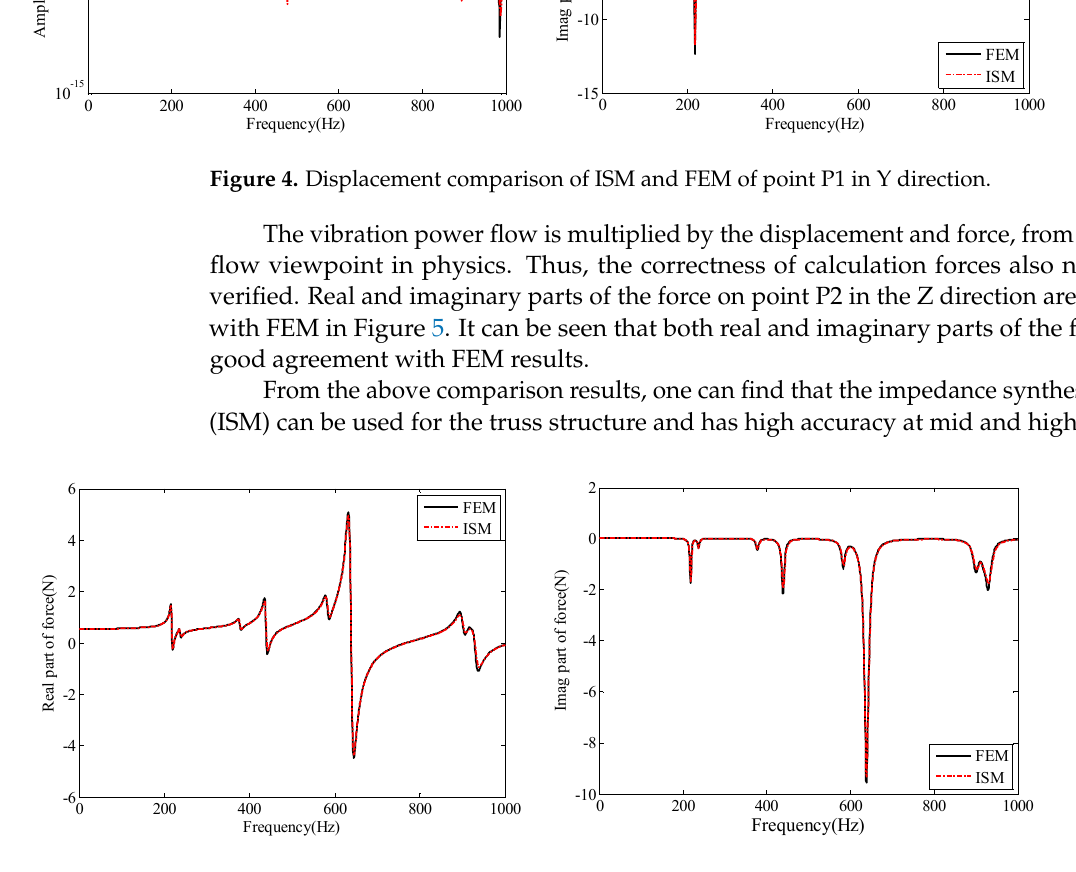
Figure 5. Force comparison of ISM and FEM of point P2 on the Z direction. From the above comparison results, one can find that the impedance synthesis method (ISM) can be used for the truss structure and has high accuracy at mid and high frequency. 3.2. Periodic Frame Structure The periodically two-dimensional truss structure is shown in Figure 6. The whole calculation structure should be divided into 15 sub-structures, A1–A15, and the boundary is points P9 and P10 are clamped. The cross-section of each truss is a pipe, and the inner radius is 80 mm and 79 mm, respectively. A harmonic excitation is applied on point P1 in the z-direction. The Young’s modulus, density, and Poisson’s ratio are 210 GPa, 7800 kg/m 3 and 0.3, respectively. The mesh size of the finite element model is 0.01 m, there are 1864 beam elements in total, and the mass is 155.33 kg. Figure 6. Scheme periodic frame structure. The y- and z-direction displacements of point P2 in the 1~1000 Hz domain are com- pared with FEM results in Figure 7. The two results are in excellent agreement.